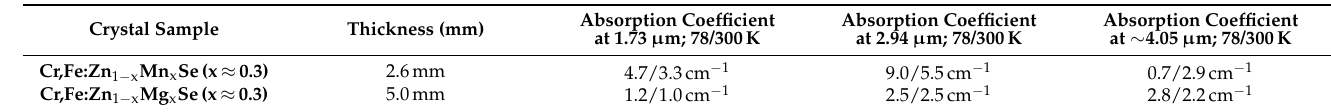
Table 3. Absorption coefficient values of Cr,Fe:Zn 1 − x Mn x Se (x ≈ 0.3) and Cr,Fe:Zn 1 − x Mg x Se (x ≈ 0.3) crystals at three excitation wavelengths used for temperatures of 78 and 300K.